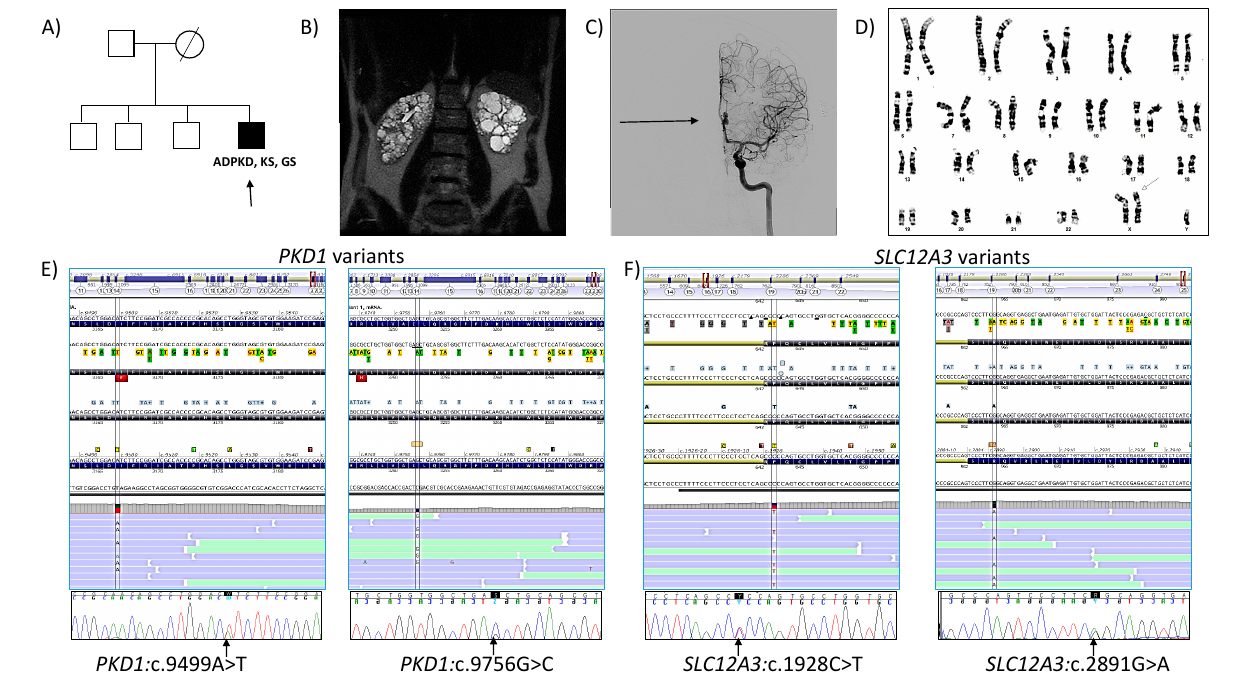
Figure 1. ( A ) Pedigree of the family. The proband (arrow). ( B ) Abdominal coronal T2 MRI of the proband at 36 years, showing a TKV of 726 mL (htTKV of 370 mL/m). ( C ) Cerebral angiography showing an aneurysm of the anterior communicating artery with hourglass image (arrow) ( D ) Cytogenetic analysis showing a 47, XXY karyotype, 50 metaphases are counted. ( E ) Molecular establishment of PKD1 variants in the proband: NM_001009944.3:c.9499A>T and NM_001009944.3:c.9756G>C, by NGS (top) and Sanger sequencing (bottom). ( F ) Molecular establishment of SLC12A3 variants in the proband: NM_0000339.3:c.1928C>T and NM_0000339.3:c.2891G>A, by NGS ( top ) and con- firmed by Sanger sequencing ( bottom ). ADPKD, Autosomal dominant polycystic kidney disease; KS, Klinefelter syndrome; GS, Gitelman